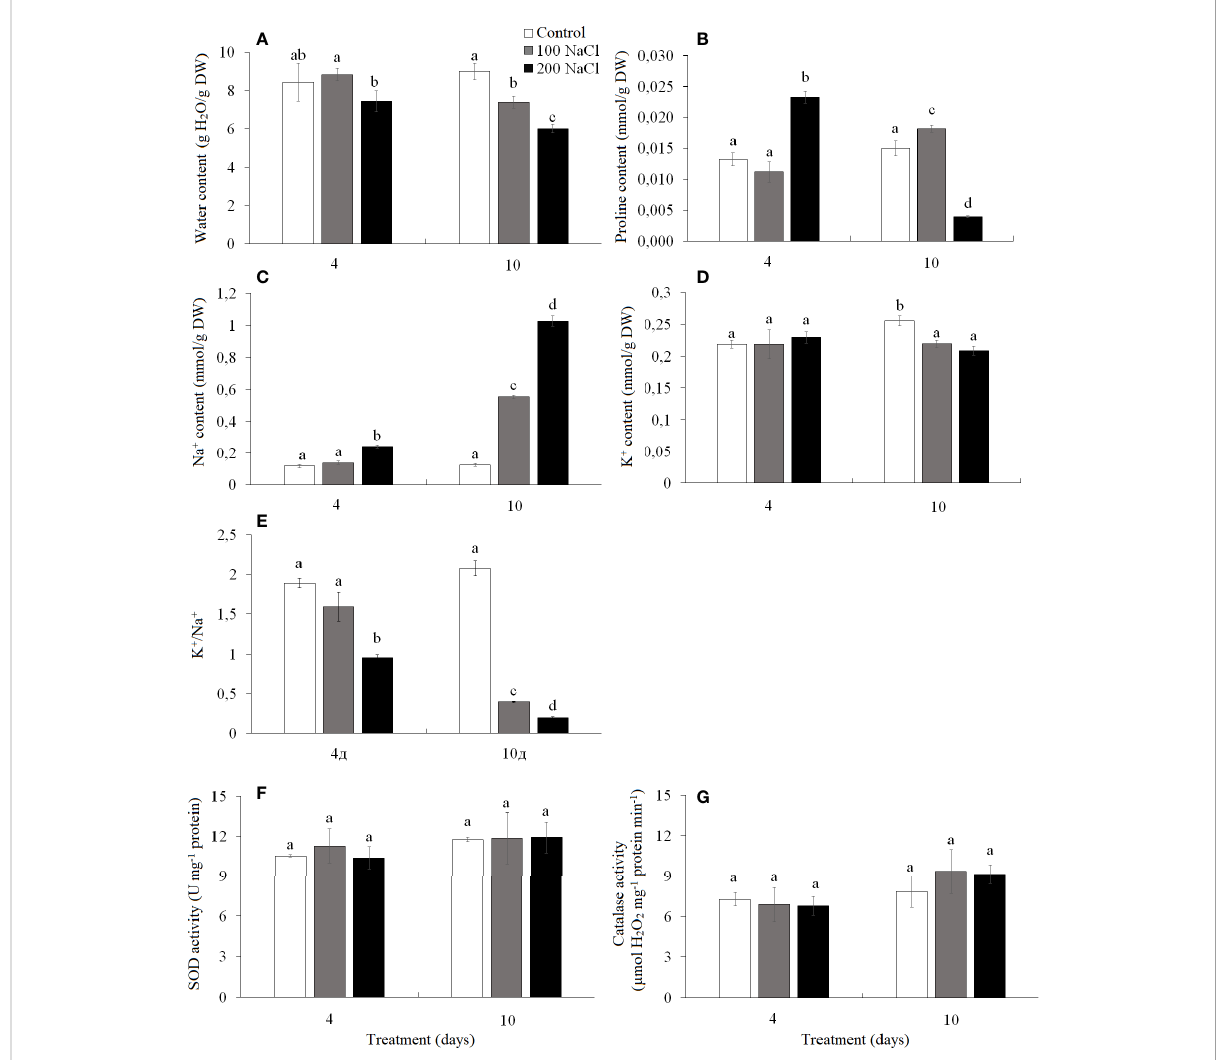
FIGURE 5 Effect of 4- and 10-day treatments with low (100 mM NaCl) and moderate (200 mM NaCl) salinity on the contents of water (A) , proline (B) , Na + (C) , and K + (D) , on the ratio of K + /Na + (E) and on activities of catalase (F) and SOD (G) in Kochia prostrata shoots. Values are means ± standard errors of one experiment with three biological replicates. The different letters show statistically different means at P ≤ 0.05 (Tukey